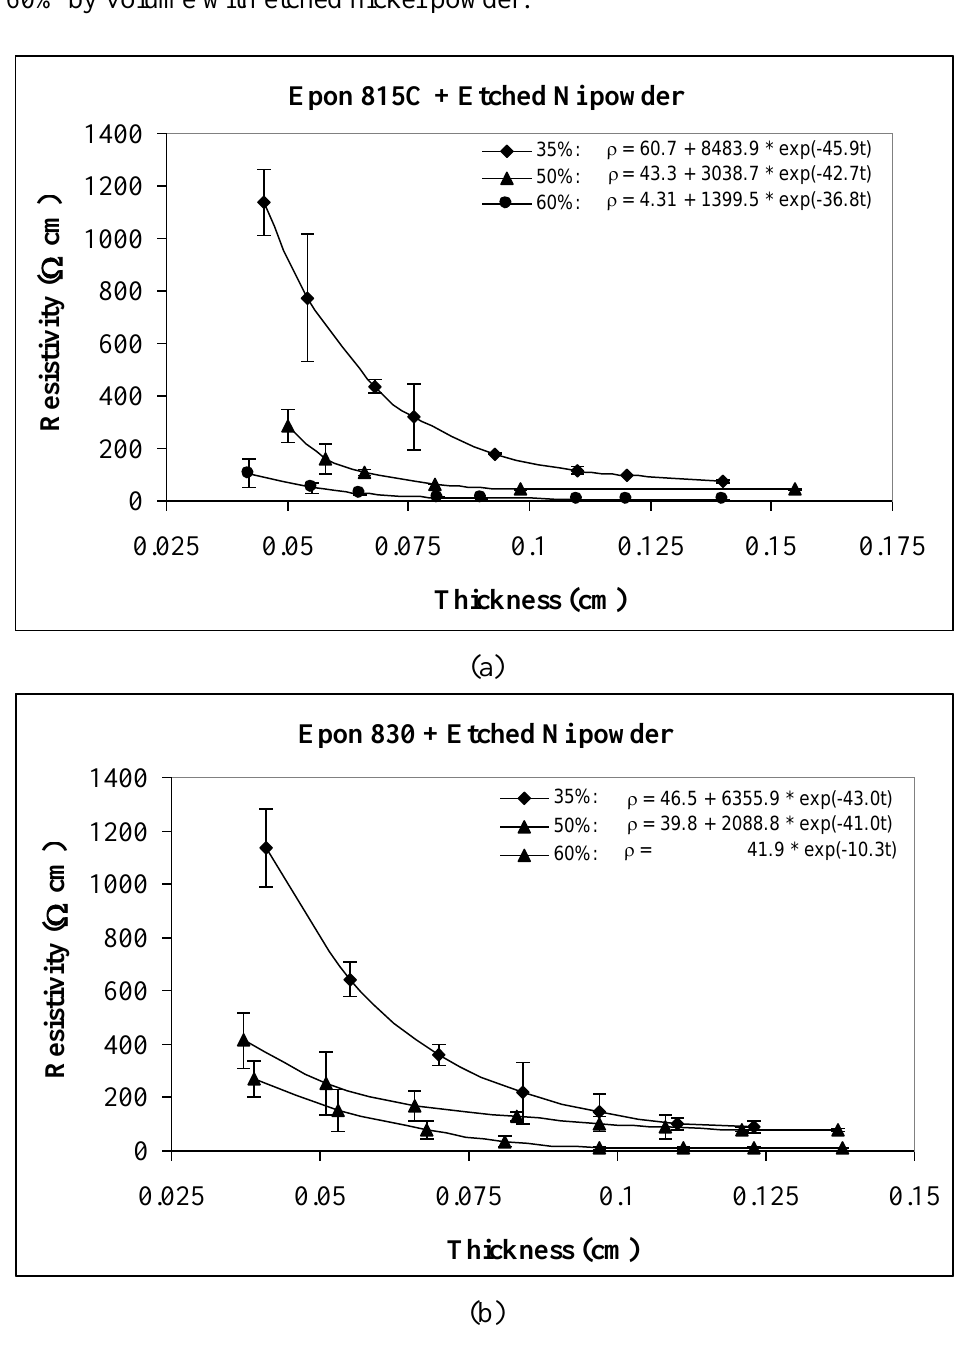
Figure 6. Thickness-dependent resistivity of Epon 815C ( a ), and 830 ( b ) films filled 35%, 50%, 60% by volume with etched nickel